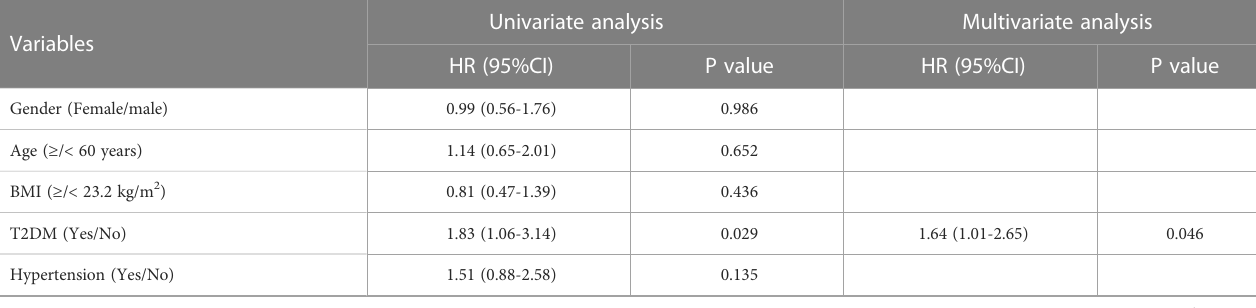
TABLE 4 Univariate and multivariate COX regression analyses of 5-year overall